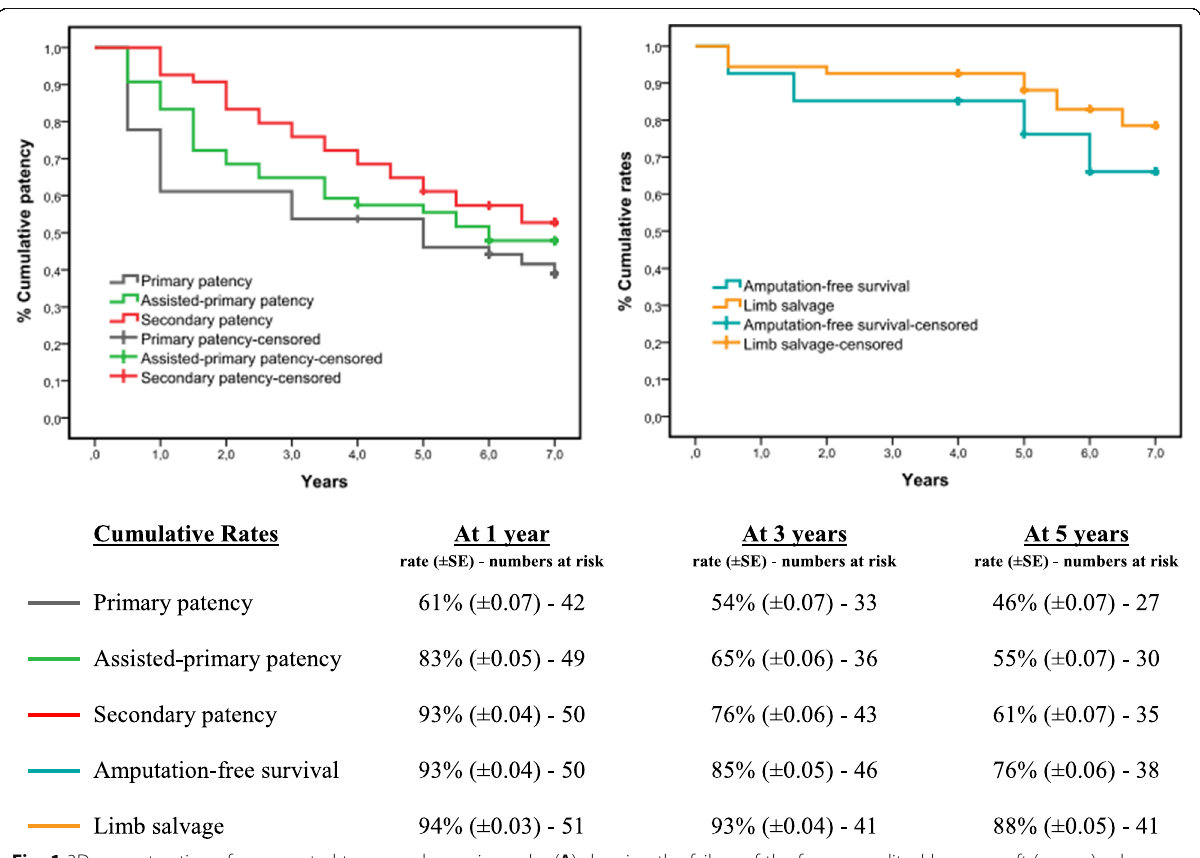
Fig. 1 3D reconstruction of a computed tomography angiography ( A ) showing the failure of the femoropopliteal bypass graft (arrows), whose target is the below-knee popliteal artery, and complete occlusion of the left superficial femoral artery, immediately after its origin, confirmed by a digital subtraction